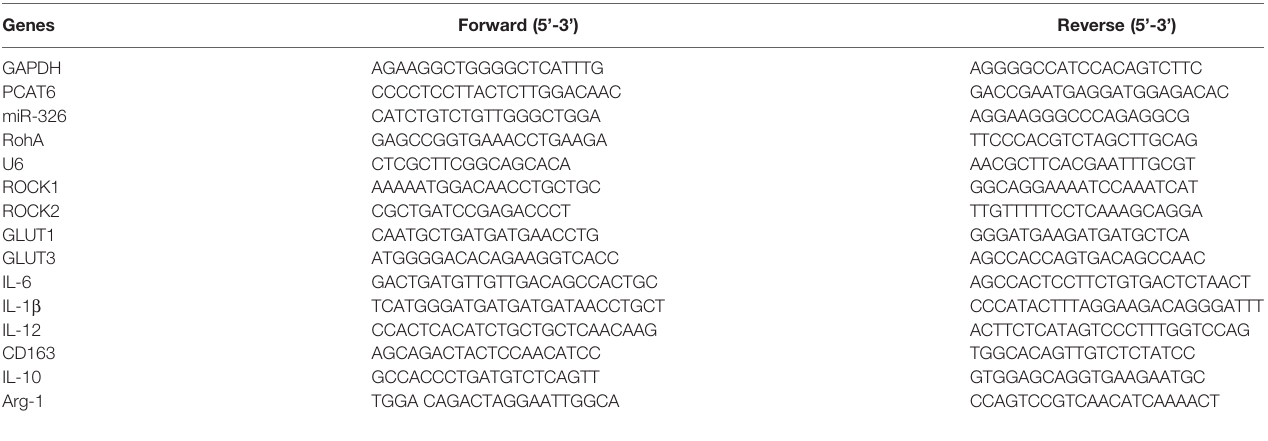
TABLE 1 | Primers for real-time PCR.